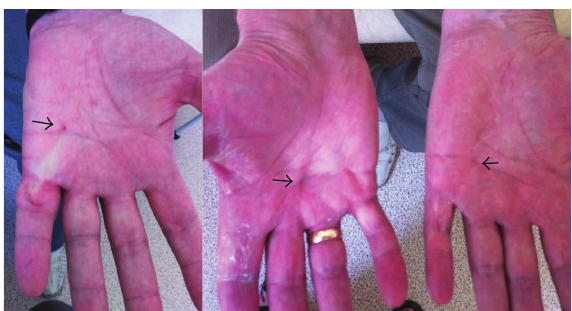
Figure 2: Hands of Probands III-2 and III-3. Arrows indicate contracture site. Distal muscle atrophy of